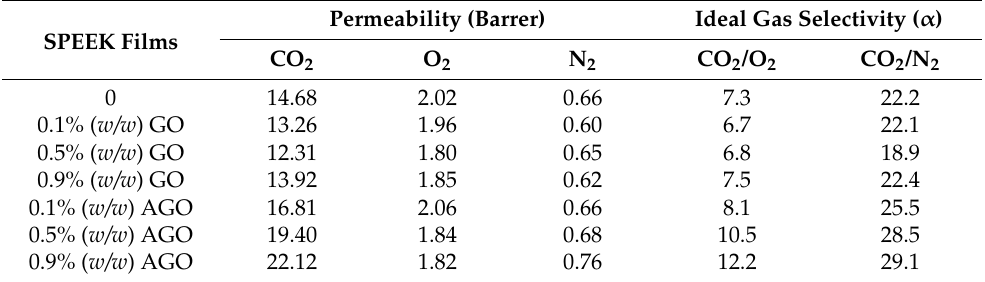
Table 1. Gas permeability of films for pure